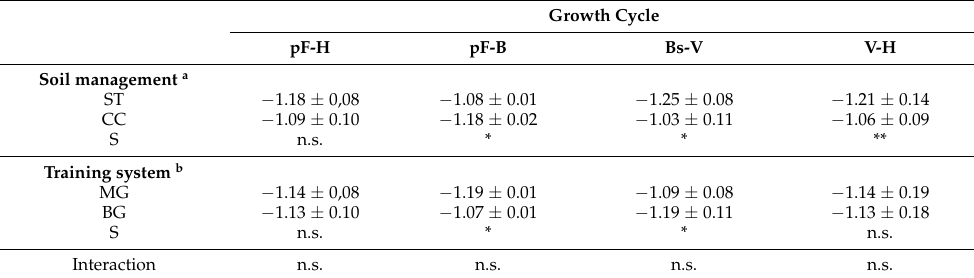
Table 3. Averaged water stem potentials ψ stem (MPa) over all the pre-flowering/harvesting (pF-H), pre-flowering/berry-set (pF-B), berry-set/ver á ison (Bs-V) and ver á ison-harvesting (V-H) stages, of Negroamaro berry growth in soil management and training system treatments.